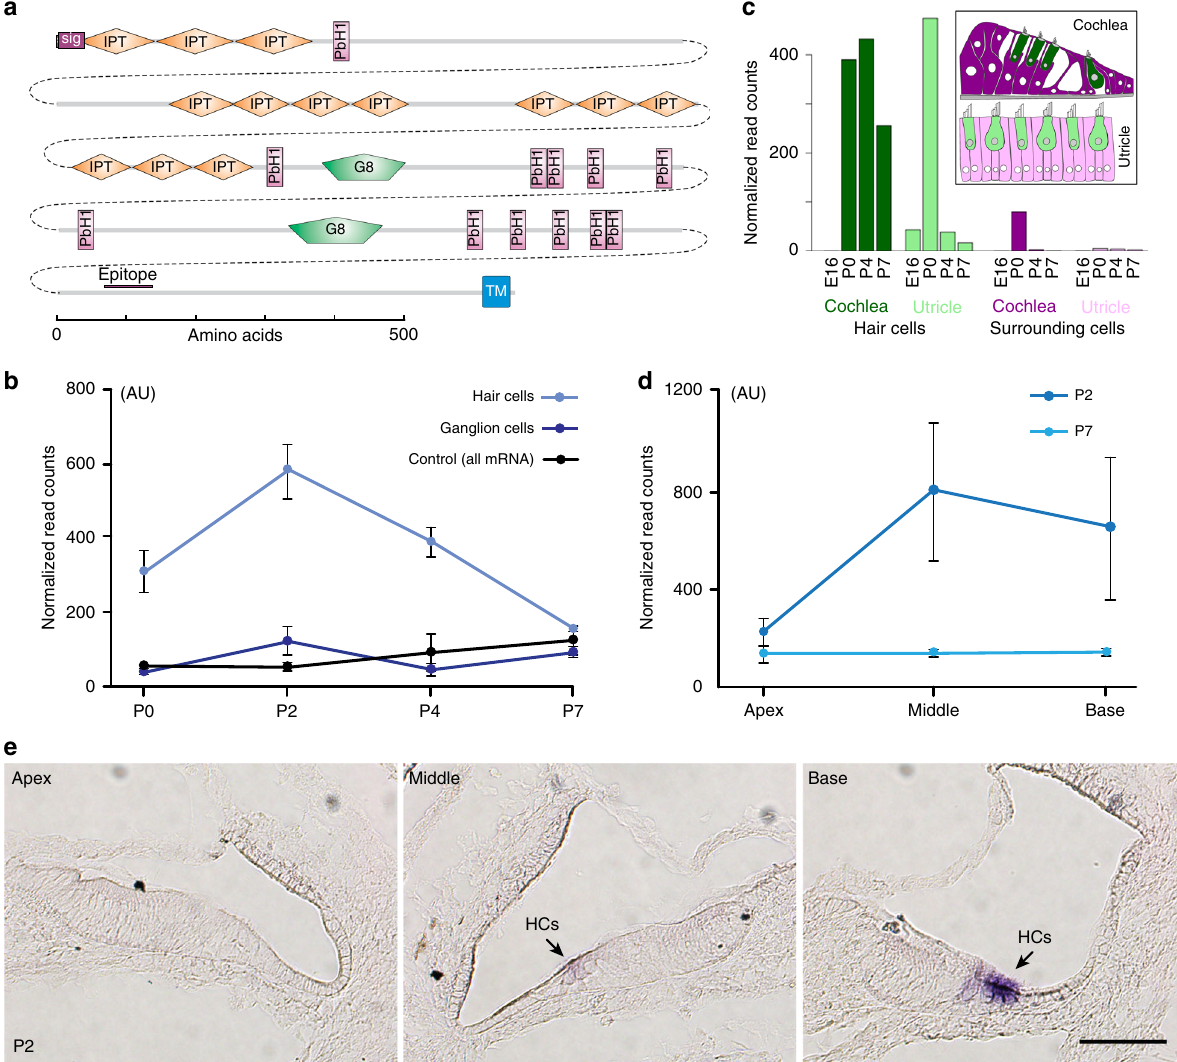
Fig. 2 PKHD1L1 domain structure, transcription, and translation levels. a Domain structure of PKHD1L1. PKHD1L1 is 4249-aa long, with a single- transmembrane domain (TM) and an 8-aa intracellular C terminus. Shown also is the epitope for the commercial antibody used (NBP2-13765). b Pkhd1l1 translation by hair cells and ganglion cells vs. control (all mRNA) for P0-P7 mice. c Relative Pkhd1l1 mRNA levels in hair cells vs. surrounding cells in cochlea and utricle 29 . Inset: color coding of cell types. d Pkhd1l1 translation by hair cells and ganglion cells vs. control (all mRNA) along the cochlea at P2. e RNA in situ hybridization showing an increase of Pkhd1l1 mRNA levels, apex to base, in hair cells at P2. Pkhd1l1 mRNA level is higher in OHCs than IHCs. In the basal turn, a faint Pkhd1l1 mRNA signal is visible in the IHCs. Scale bar: 50 µ m. Data shown as mean ± s.e.m. Source data are provided as a Source Data fi